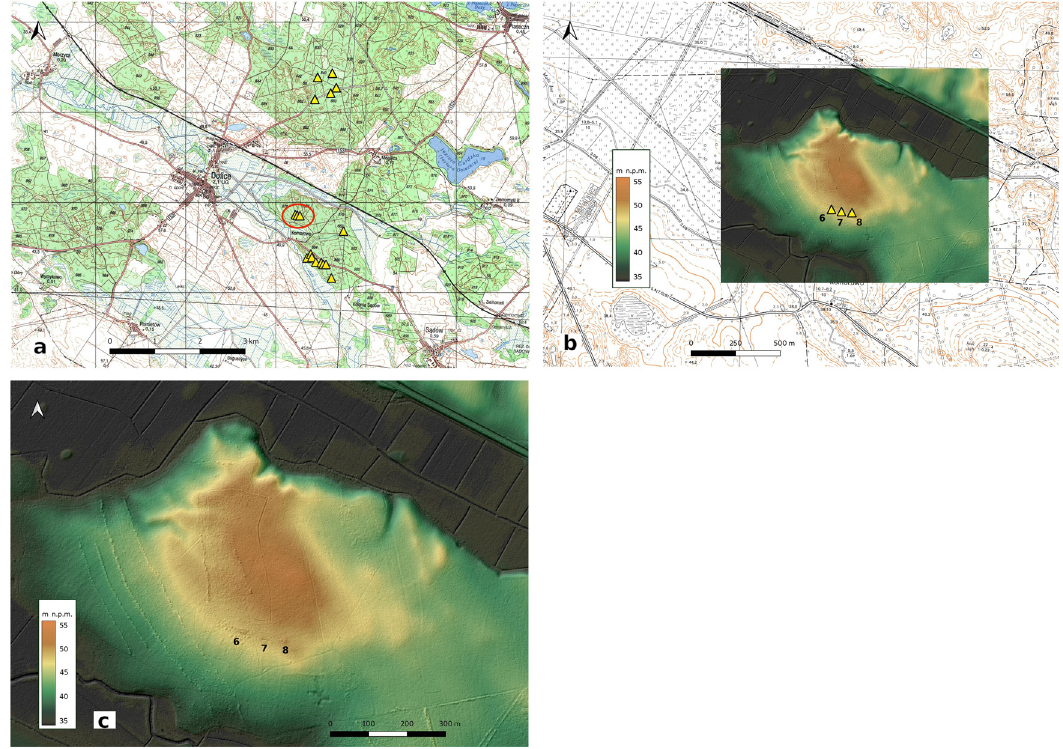
Figure 11: The Dolice - Komorowo North megalithic group shown among other groups of megalithic tombs in the Dolice mega - lithic group ( a ) , the group presented on a hypsometric map fragment ( b ) and its digital terrain model in hypsometric colours ( c ) ( M. Schiller )